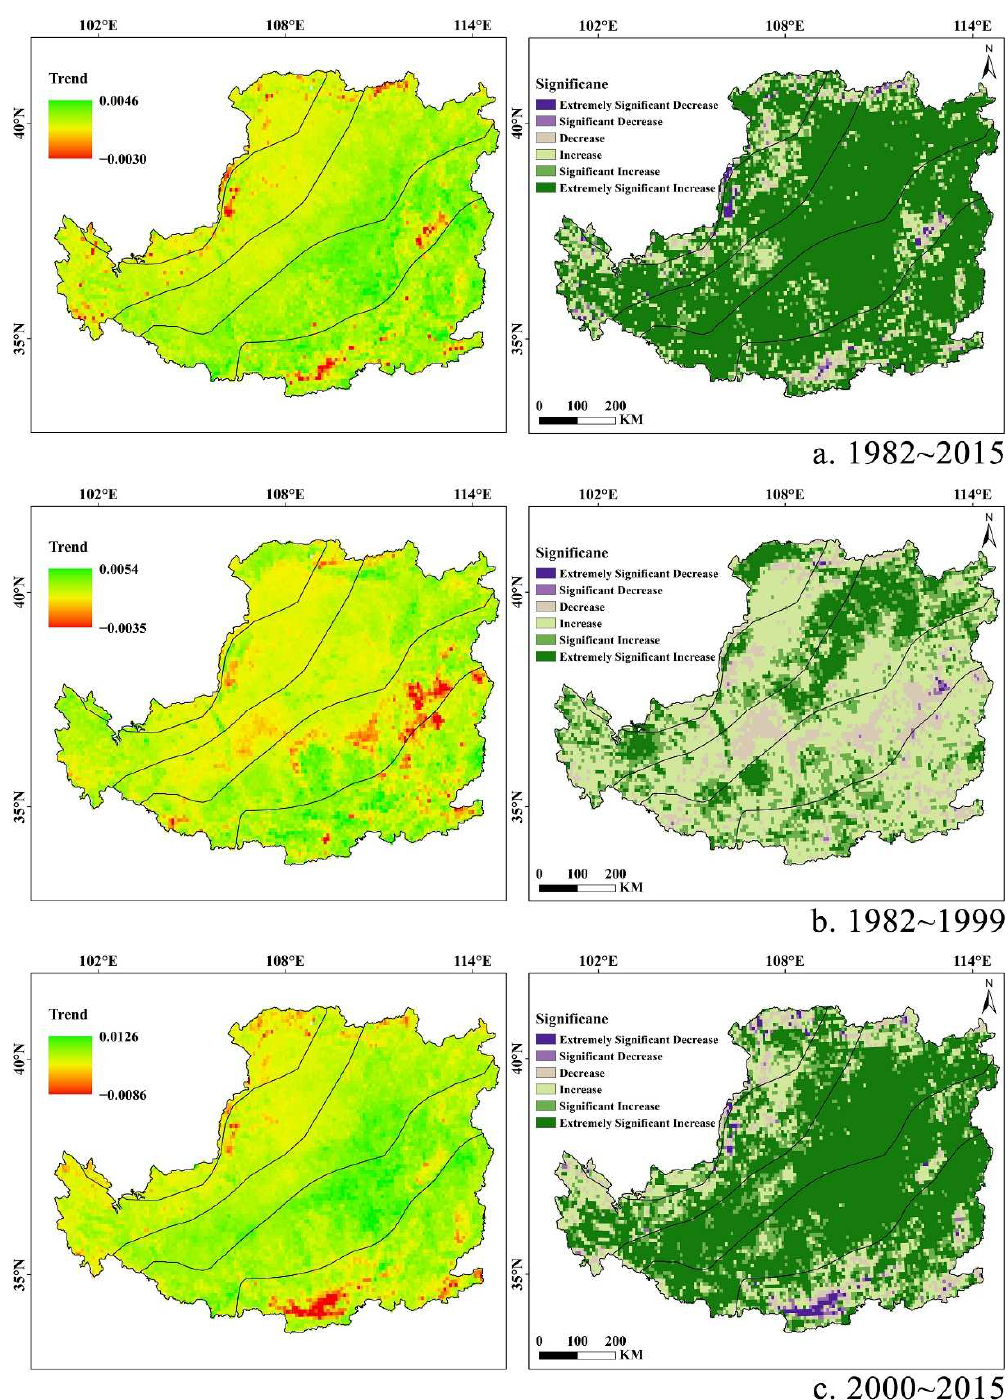
Figure 4. Spatial patterns of the NDVI changes and corresponding p values for ( a ) 1982–2015; ( b ) 1982–1999 (BBP); ( c ) 2000–2015 (ABP). The averaged trend of NDVI change in BBP was 0.0094 decade −1 spatially, and the areas showing increasing and decreasing trends accounted for 88.6% and 11.4%, respectively (Figure 4b). However, the trend of NDVI change in ABP was 0.031 decade − 1 spatially, nearly 3 times of the BBP changes. The proportion of areas with an extremely significant increasing trend rose obviously from 19.2% in BBP to 60.3% in ABP, and they were detected mainly in the central LP where the GGP occurred (Figure 4b,c).